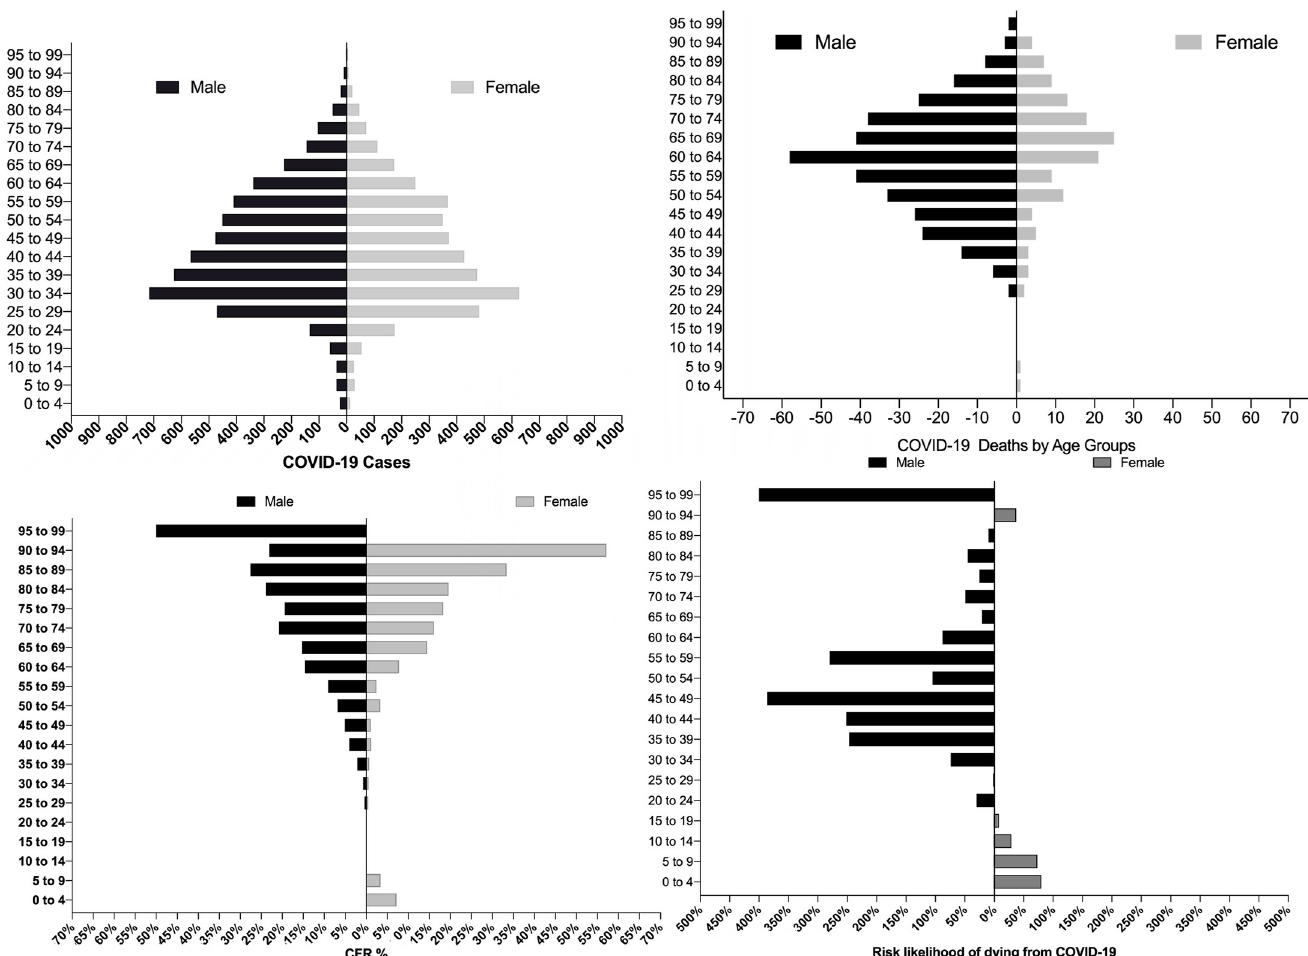
Fig 1. COVID-19 cases and deaths in Ecuador by age and sex. Top panel: Age pyramids for confirmed cases and officially reported deaths. Lower panel: Case fatality rate (%) and risk likelihood of dying from COVID-19, for females (blue) and males (purple).